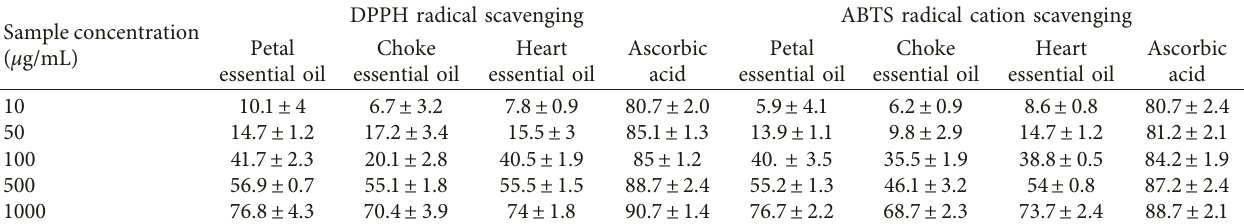
Table 4: Scavenging activities of essential oils derived from the petal, choke, and heart of C. scolymus L. head. Sample concentration ( µ